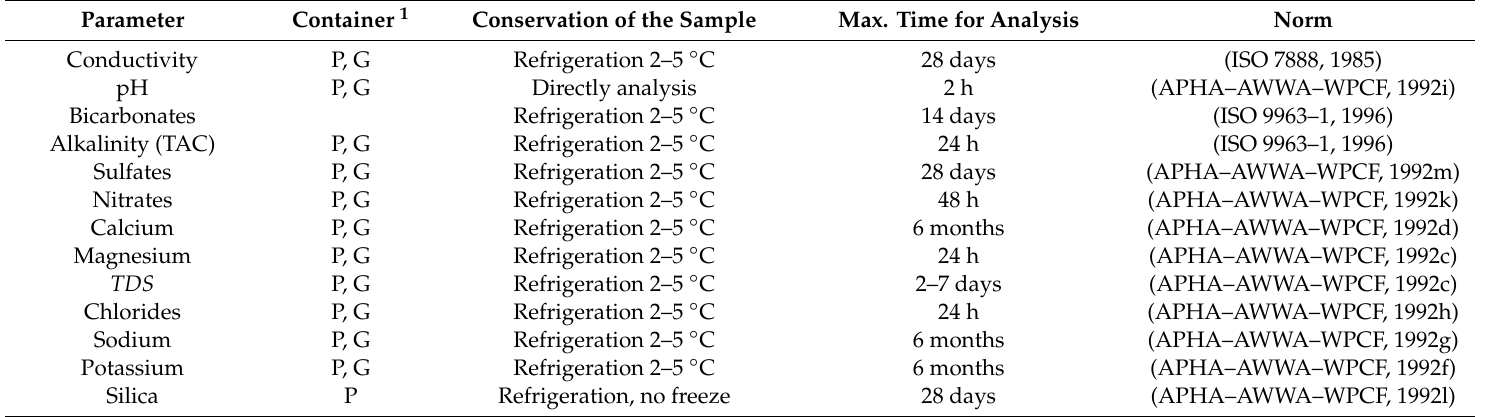
Table 2. Special requirements taken into account when taking the samples on the basis of the type of parameter to be analyzed. The type of container used is specified, as well as the method and maximum storage